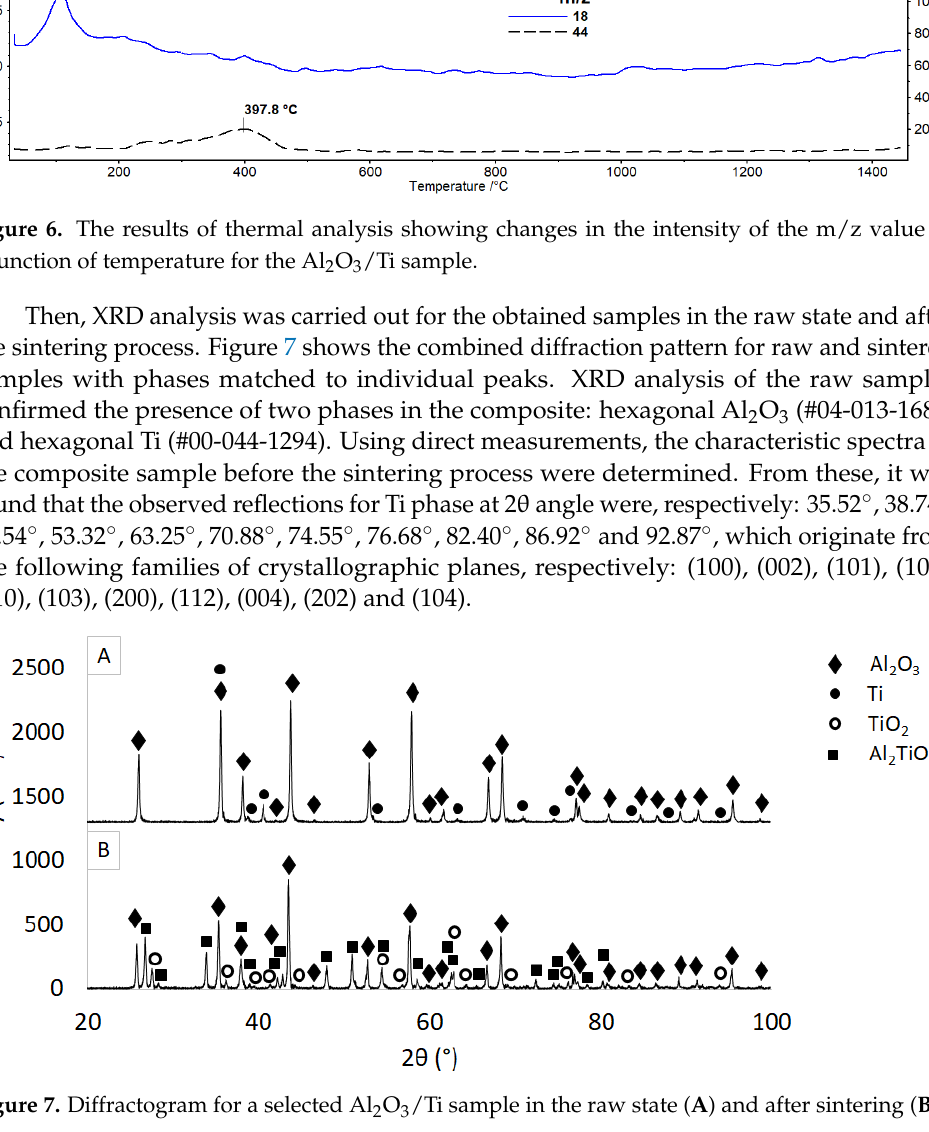
8 of 13 Figure 5. Thermal analysis results—DTA, TG and DTG curves. Then, Figure 6 presents the results of thermal analysis showing changes in the inten- sity of the m / z (mass to charge ratio) value as a function of temperature for the Al 2 O 3 /Ti sample containing 50% vol. of the solid phase, including 10% vol. of the metallic phase. For the test sample, two signals from the mass spectrometer with m / z values of 18 and 44 were recorded, which can be attributed to water and CO 2 , respectively. Both curves show peaks with maxima of 109.1 °C for the m / z 18 curve and 397.8 °C for the m / z 44 curve. They